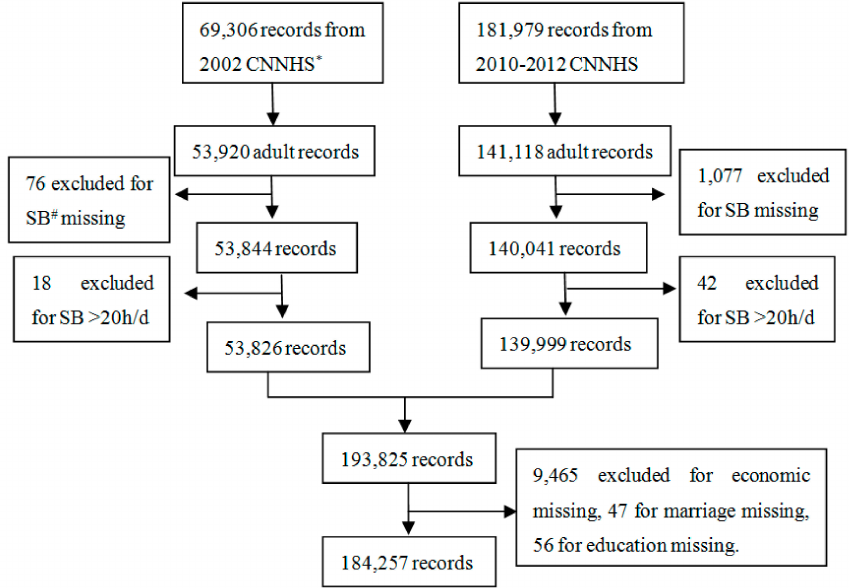
Figure 1. The flowchart of data cleansing. ( * CNNHS: China National Nutrition and Health Survey; # SB: sedentary